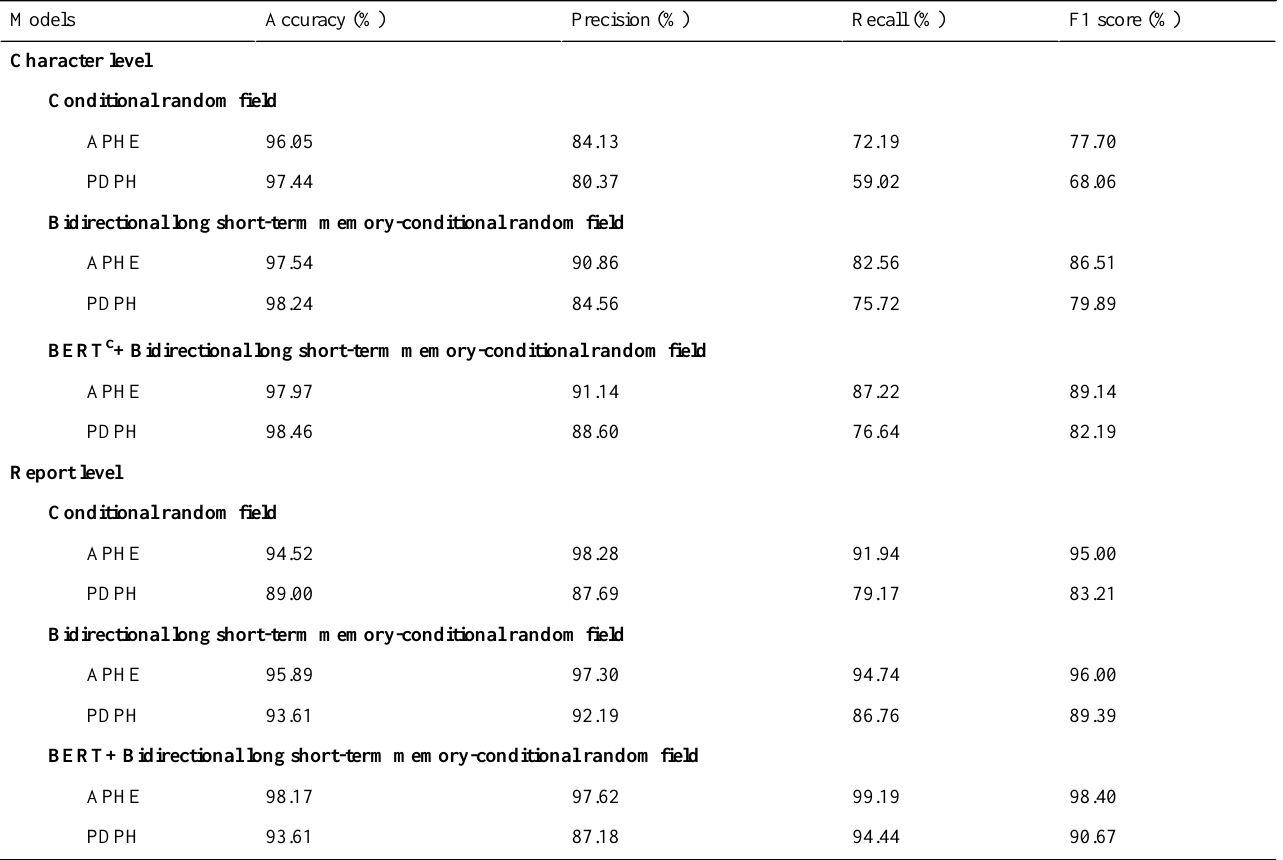
Table 2. Recognition performance of APHE a and PDPH b by using different models at the character level and report level.